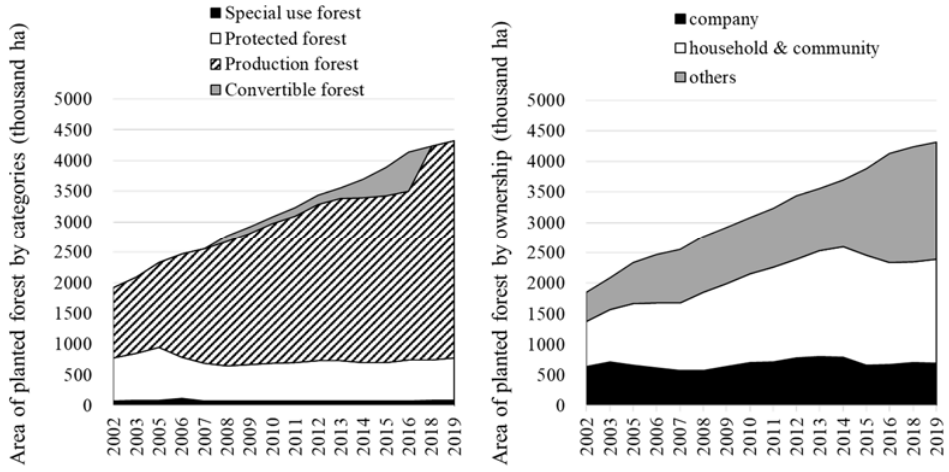
Figure 3. Transition of planted forest area by categories and ownerships. Source: [7].